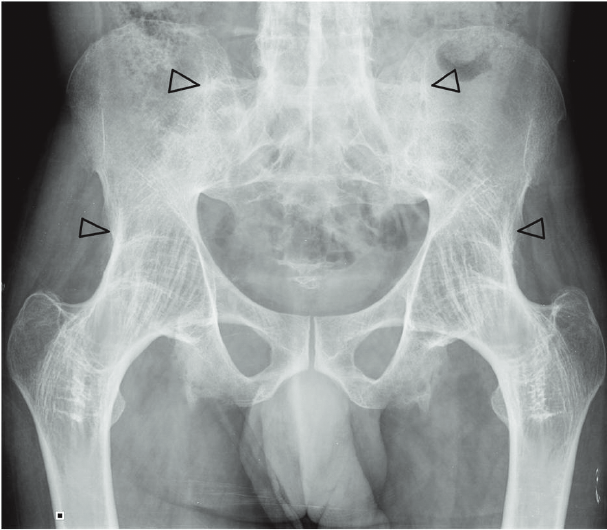
Fig. 4. Antero-posterior view of the pelvis. The open arrowheads indicate marked ankylosis of the hips and sacro-iliac